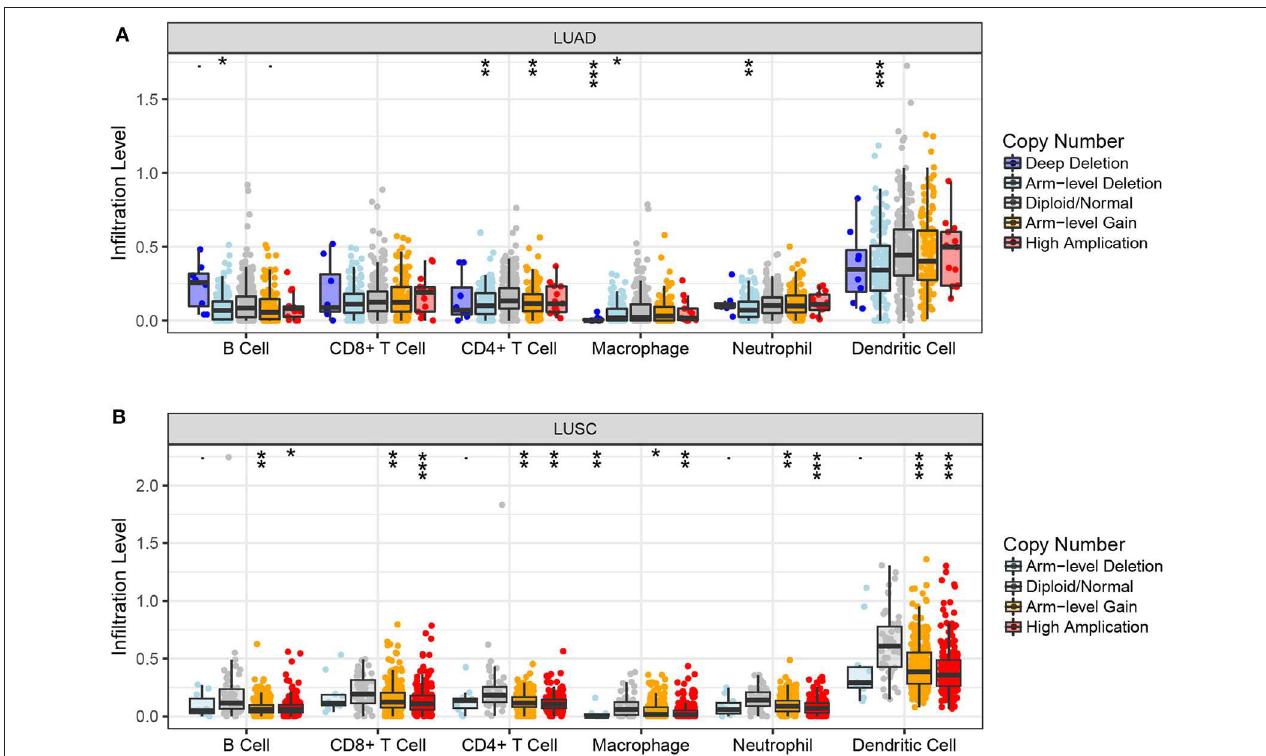
FIGURE 2 | Associations between ACK1 / TNK2 gene copy numbers and immune cell infiltration levels. Association between ACK1 / TNK2 copy numbers and immune cell infiltration levels in LUAD (A) and LUSC (B) cohorts. * p < 0.05; ** p < 0.01; *** p <